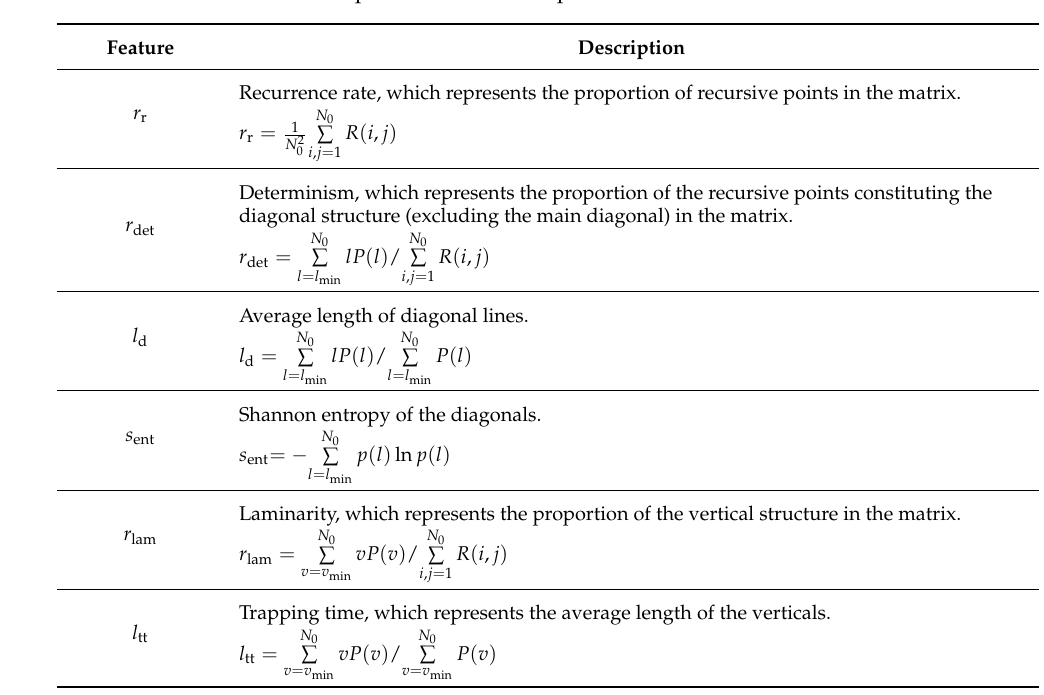
Table 2. Features from the shape of the recurrence plot